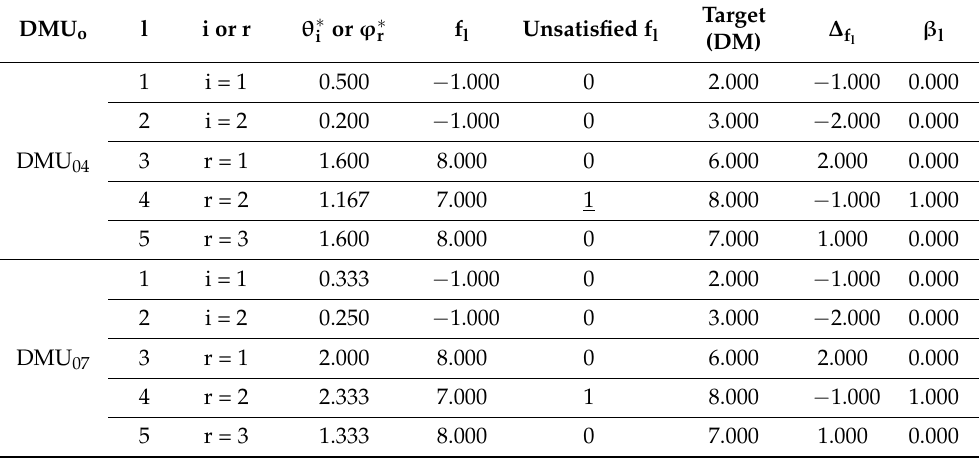
Table A5. Calculated parameters through solving step 2 of the STEM model (p = 1) considering two DMUs (the second case